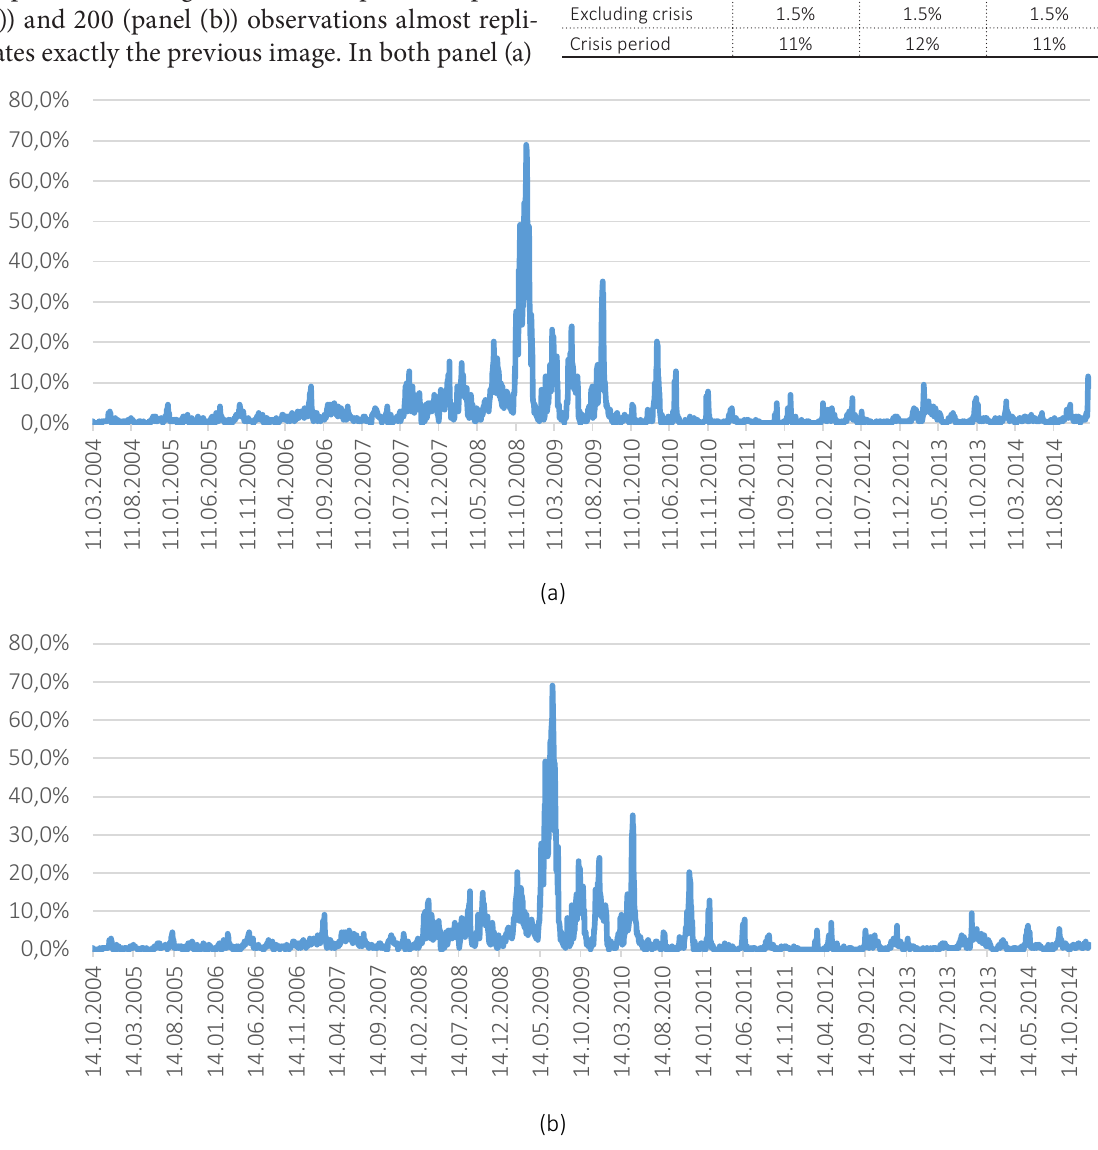
Note: Figure 9 depicts the percentage of individual stock returns, which rejected the equality hypothesis at each given date, measured as the number of stocks for which the hypothesis was rejected at every given sample, over the total number of stocks. The rolling sample size was set at 1,000 daily observations and the forecast sample at 50 and 200 for panels (a) and (b), respectively. The dates depict the end-date of each rolling sample. Figure 9. Fifty (50) and two-hundred (200) observation forecast sample using Wilcoxon rank-sum